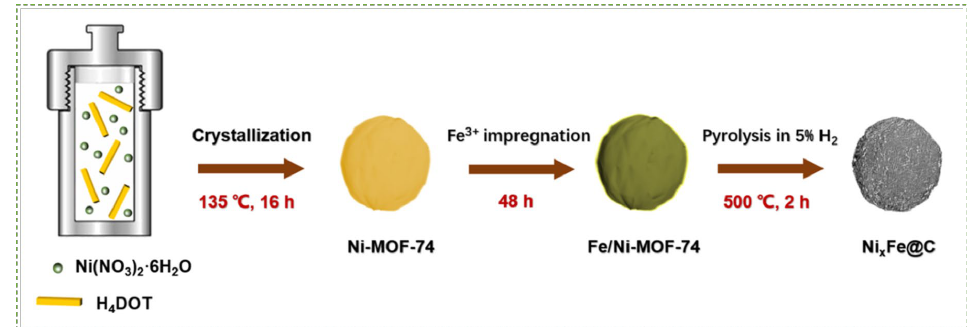
Figure 4. Schematic of the synthesis of the Ni 7 Fe@C catalyst by pyrolyzing Ni-MOF-74. Reproduced with permission from Li et al. [77], Iron promoted MOF-derived carbon encapsulated NiFe alloy nanoparticles core-shell catalyst for CO 2 methanation; published by Elsevier, 2022. New core-shell nanostructure based on cobalt (Co) catalysts have been successfully fabricated by Cui et al. [78] to study catalytic performance of low temperature methana- tion. MnO-heterostructured NPs injected into porous graphitic carbon (Co/MnO@PGC) were synthesized via a single-step pyrolysis of bimetal CoMn@MOF-74. The resulting nanocomposite features an enriched Co/MnO heterointerface and exhibits excellent cata- lytic performance for low-temperature CO 2 methanation. The synthesized Co/MnO@PGC catalyst allowed CO 2 molecules to activate faster at a low heat of 160 °C over 99% selec- tivity with high STY CH4 of 0.14 μmolCH 4 s − 1 gcat − 1 . As the temperature reached 240 °C, CO 2 conversion and space–time yield (STY CH4 ) rose to 32.1% and 13.34 μmol CH4 gcat − 1 s − 1 , respectively. At a high pressure (30 bar), STY CH4 can reach up to 5.60 μmol CH4 s −1 gcat −1 at 160 °C, which is even comparable to that of the optimal level of Ru-based catalysts. These results indicate that the synergistic interactions between Co and MnO NPs at the Co-MnO heterointerface are responsible for enhancing the catalytic activity toward CH 4 production at a low temperature. In addition, the Co/MnO heterostructured NPs encapsulated into PGC play an important role in preventing metal particle aggregation and improving ther- mal stability. High TOF CH4 suggested that the Co/MnO heterointerface formed inside the PGC of Co/MnO@PGC can significantly boost its activity of low-temperature (160–220 °C) CO 2 methanation. Core-shell metal@metal oxide particles can be promising as high thermal-conducting support materials owing to the high thermal conductivity of metal and excellent surface structural properties of the metal oxide itself. Various supports, such as Al 2 O 3 [80], CeO 2 [81], ZrO 2 , SiO 2 [60], or zeolites [60] have been proposed as metal oxide shell to protect the active metals at the core. In addition, Le et al. [82] synthesized a Ni/Al@Al 2 O 3 CSN catalyst for CO and CO 2 methanation by using hydrothermal surface oxidation (HTSO). Ni/Al@Al 2 O 3 has selectively yielded carbonate and formate species, which suppress the CO intermediate. The confinement effect helped the CSN catalyst lower the activation en- ergy barriers (74 kJ/mol), which outperforms the activation energy of conventional cata- lysts, namely, Ni/Al 2 O 3 (80 kJ/mol) and Ni/SiO 2 (89 kJ/mol). Apparently, Ni/Al@Al 2 O 3 CSN can successfully enhance the catalytic CO 2 adsorption owing to its high Ni dispersion and strong CO 2 binding. Meanwhile, Ilsemann et al. [60] prepared Co@SiO 2 and Co@Silicalite-1 catalysts via a solvothermal method to encapsulate the Co NPs inside two mesoporous structures of sil- ica shells (Figure 5). They found that Co@SiO 2 improves the catalytic activity in low-tem- perature CO 2 methanation (230°C–400 °C) by suppressing the side reaction (RWGS), which results in highly selective CO 2 hydrogenation to methane. The thermal stability provided by mesoporous silica could preserve the active Co metals at elevated tempera- tures. However, CO methanation causes slight coking, resulting in a shift of kinetic stabil- ity and reduction in methane yield. Similarly, a silicalite-1-confined Ni catalyst was pre- pared through the selective desilication of the molecular sieve to produce extra voids and